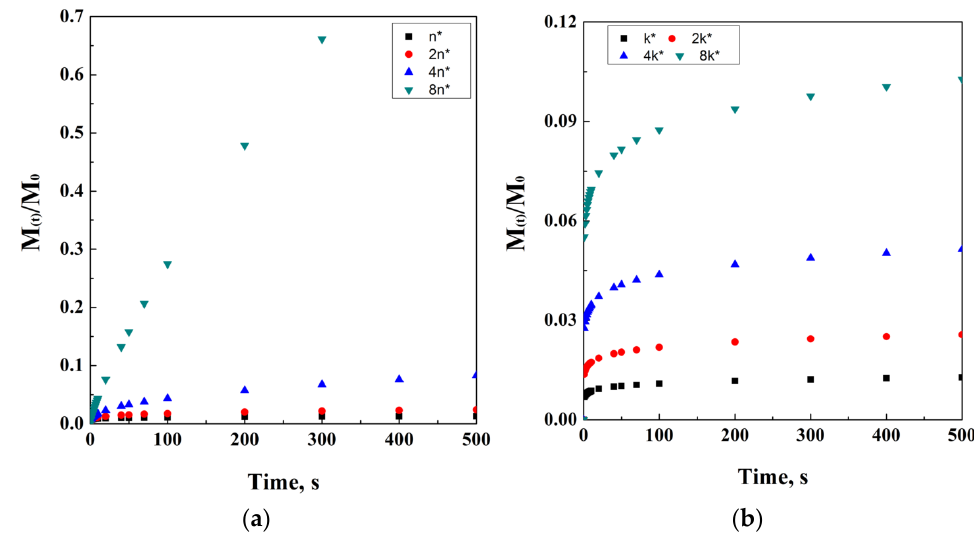
Figure 5. Power law at different exponent values ( a ) and k coefficients ( b ).